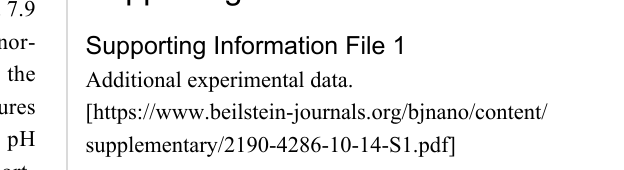
ilar to those obtained at 3.9 wt % whereas the mesostructures were found to be rather different from those obtained at 3.9 wt %. Several factors may be involved in the difference in mesostructures between the two concentrations of the reaction medium (hexagonal vs lamellar/hexagonal mixture at pH